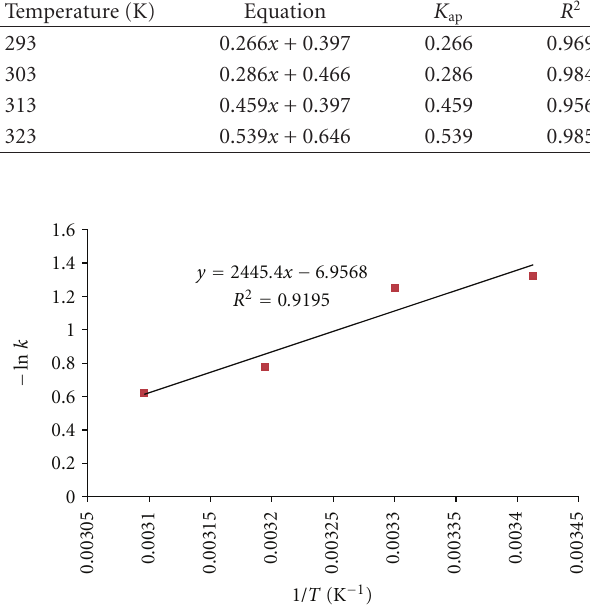
Figure 8: E ff ect of temperature on rate constants.